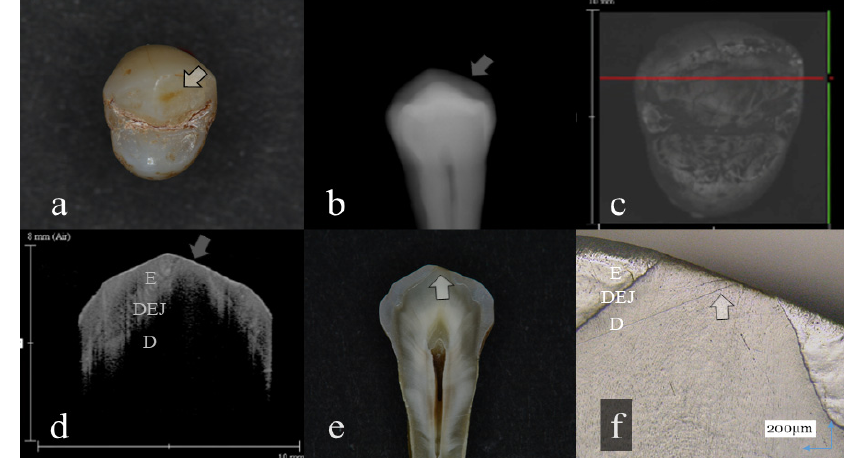
Figure 5. Tooth wear with distinct dentin exposure (score 4); ( a ): Occlusal view. Distal surface of